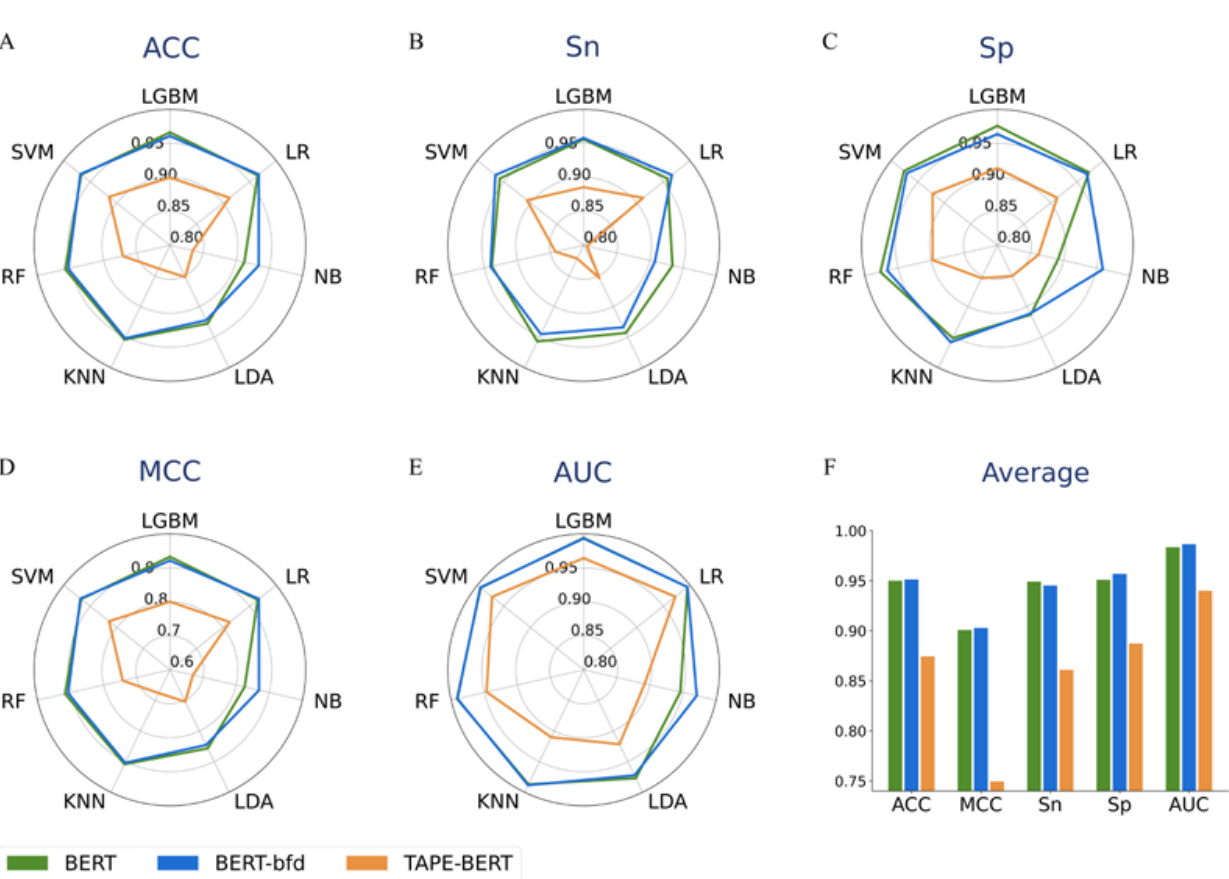
Figure 2. The 5-fold cross-validation performance of models using BERT, BERT-bfd, and TAPE-BERT features, with seven different classifiers. ( A ) is the radar map of ACC. ( B ) is the radar map of Sn. ( C ) is the radar map of Sp. ( D ) is the radar map of the MCC. ( E ) is the radar map of AUC. ( F ) is the histogram of average performance, which is the average performance obtained after the average of seven different